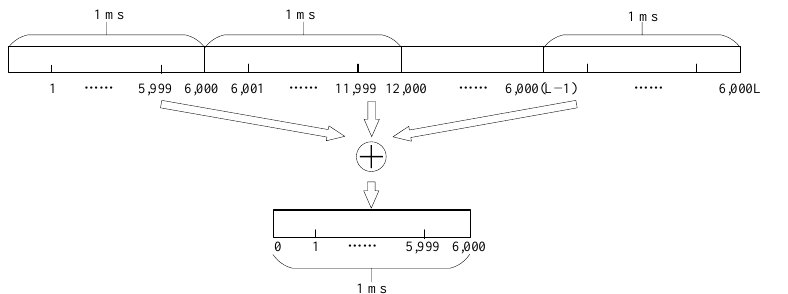
Figure 4. Schematic diagram of coherent accumulation.